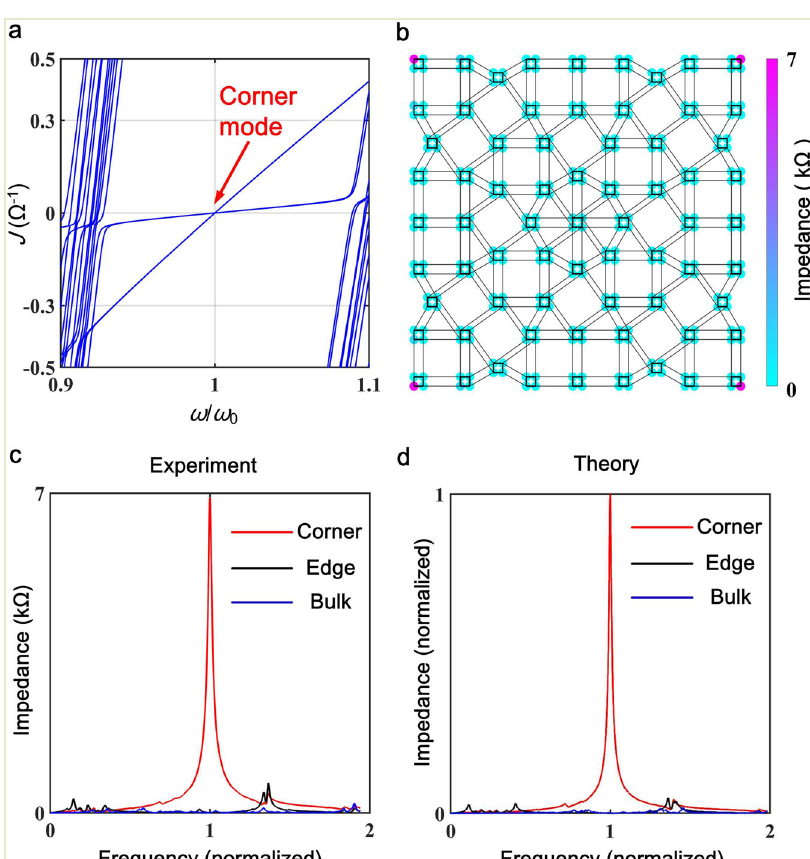
Fig. 2 Corner states on the circuit. a Spectra of the Laplacian J vs. the frequency that is normalized to the resonant frequency ω 0 . The isolated mode crossing in the gap corresponds to the topological corner states. b The experimental impedance distribution at the resonant frequency ω 0 demonstrates the spatial localization of the corner states. c The experimental two-point impedances measured between the left-up corner/edge/bulk site and another bulk site. d The theoretical two-point impedances. Both the experimental and theoretical results demonstrate the spectral localization of the corner a fi xed frequency ω 0 . The spatial distribution of the experimentally observed impedance of the corner states at ω 0 is illustrated in Fig. 2b. The impedance is maximum at the four corner sites and exponentially decays at other sites. The comparison between the experimental and theoretical impedance spectra is shown in Fig. 2c, d, which demonstrate the spectral localization of the corner modes. The maximum measured impedance reaches 7 k Ω .